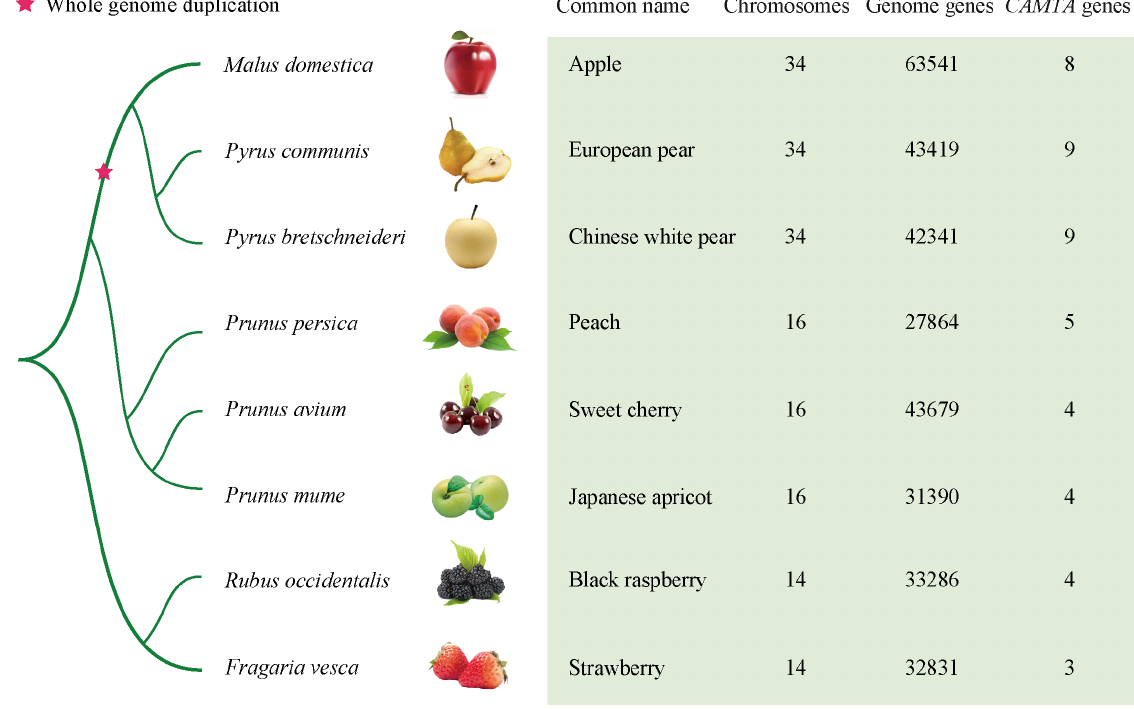
Figure 1. Phylogenetic tree and genome information of CAMTA genes in eight Rosaceae species. The pentagram indicates the occurrence of whole-genome duplication events (WGD).